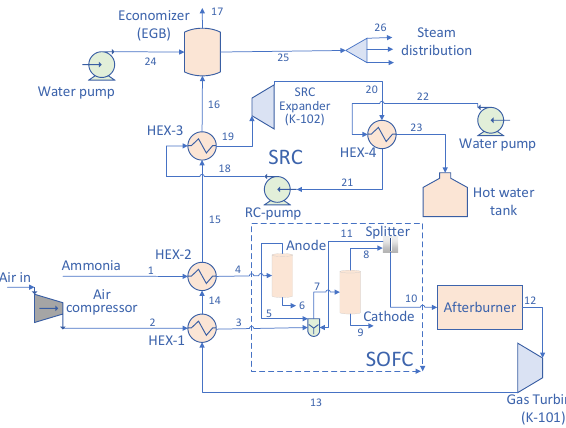
Figure 1. Schematic diagram of the SOFC-GT-SRC-EGB employing ammonia as fuel.